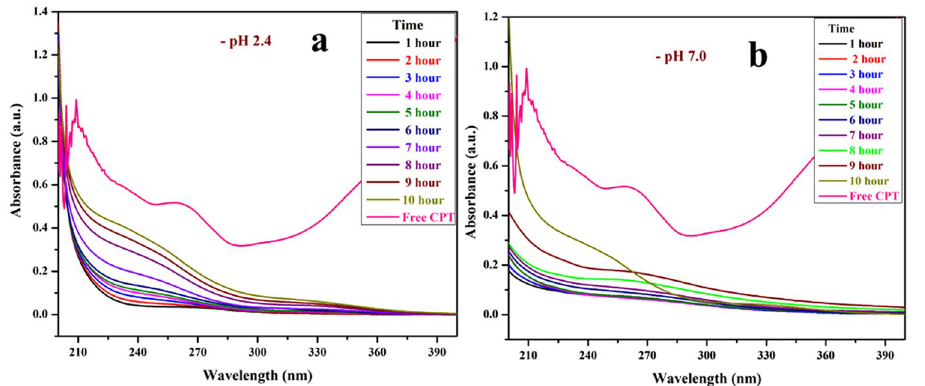
Figure 3. In-vitro drug release analysis of β -CD-EDTA-Fe 3 O 4 /CPT at pH 2.4 ( a ) and at pH 7.0 ( b